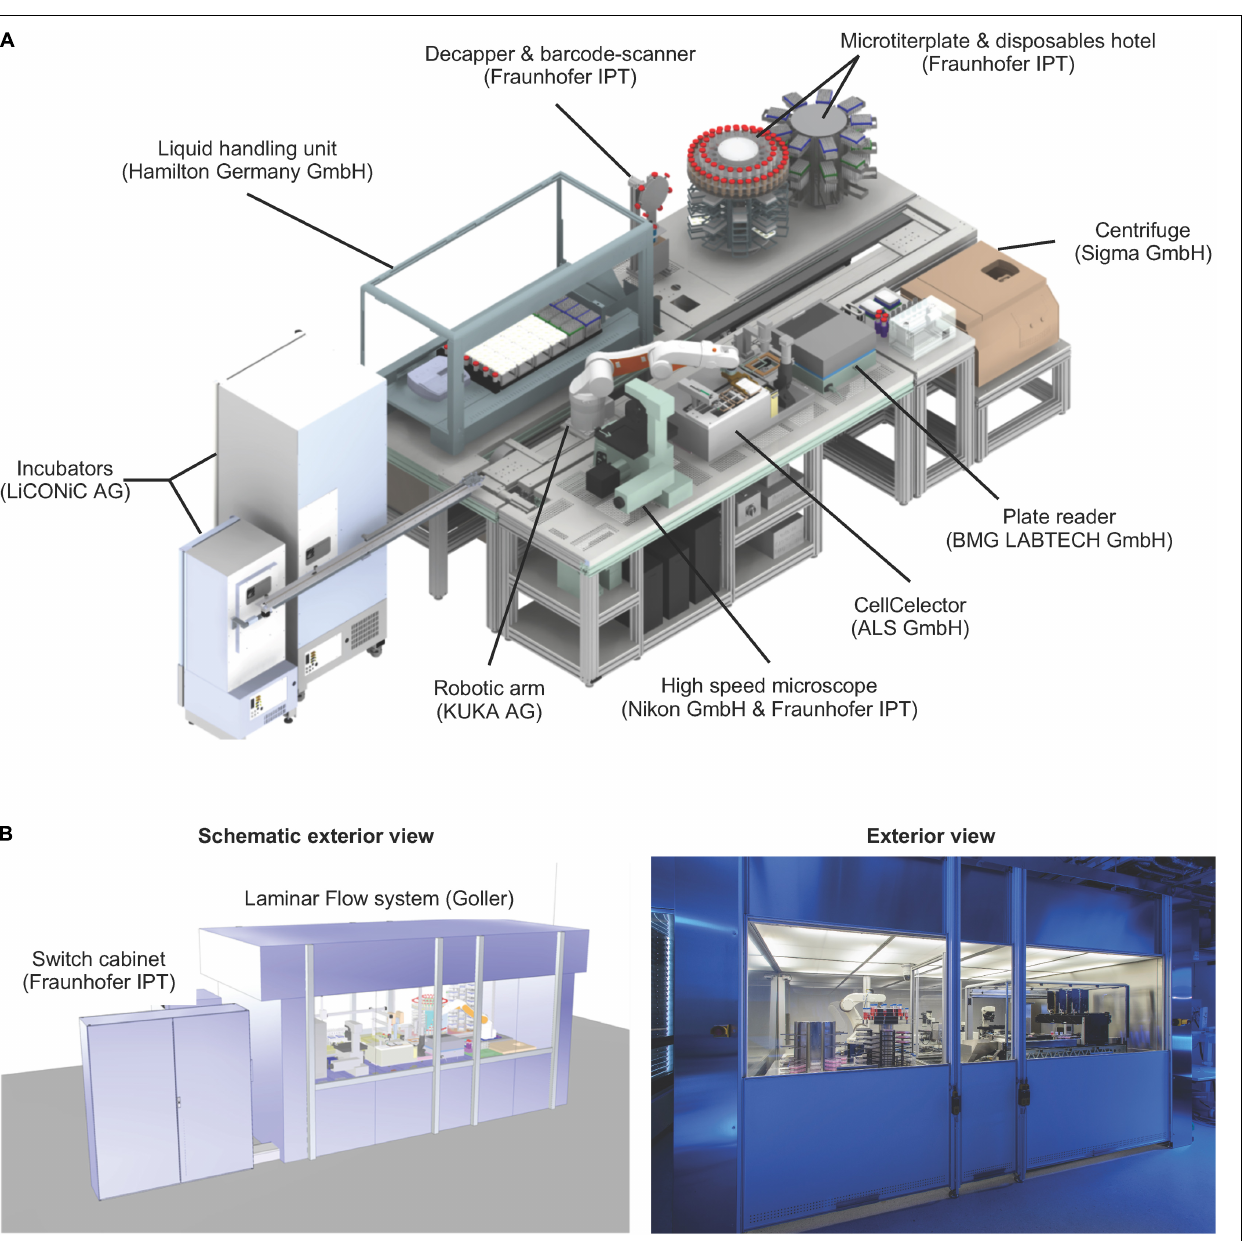
FIGURE 2 | Technical set-up of the StemCellFactory. (A) The platform includes a liquid handling unit, automated incubators, a robotic arm, a microscope, a clone picker, a plate reader, a centrifuge and a microtiter plate & disposable hotel. All units are functionally joined for culturing/reprogramming of human fibroblasts, selection of primary hiPSC clones and expansion of hiPSC lines. The manufacturer of each instrument is indicated in brackets. (B) The entire unit is encased in a clean room cabinet.